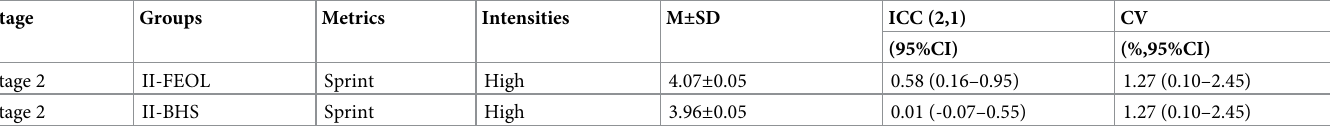
group (ICC = 0.37) for stage-I of the medium-intensity post-training sprint test, the I-FEOL group (ICC = 0.34) for the high-intensity post-training sprint test, and the II-FEOL group (ICC = 0.01) for stage-II of the high-intensity post-training sprint test.